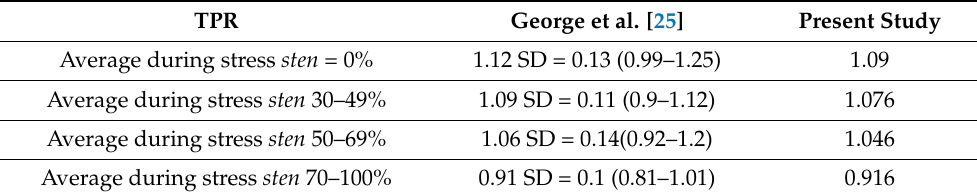
Table 2. Comparison between average stress TPR estimated by George et al. [25] and by the present study. SD stands for standard deviation. The numbers in parenthesis indicate the correspond- ing